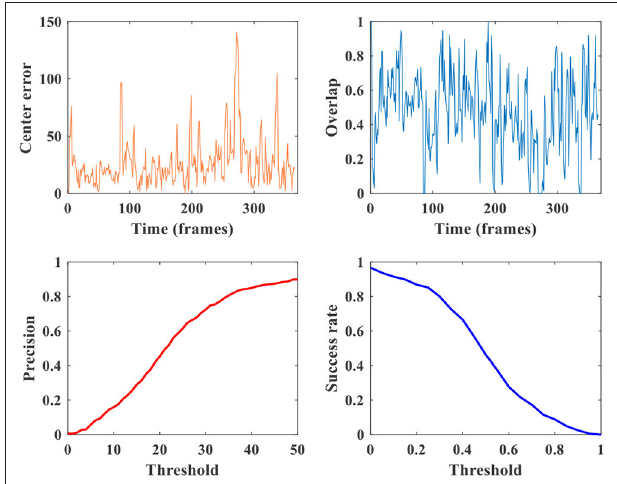
FIGURE 8 | Comparison of several metrics: center error, precision, overlap, and success rate.